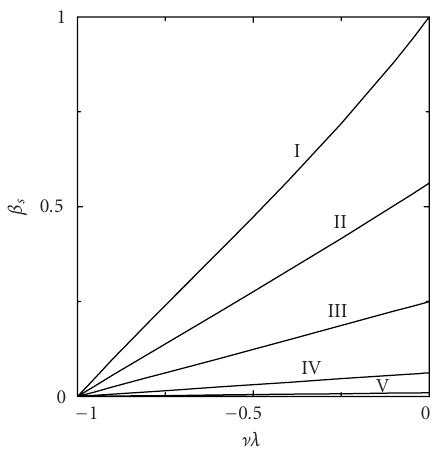
Figure 3.5. The variation of the smaller root β s of (3.10) as a function of ν λ for ν λ < 0 for various values of the nonintegrability parameter α . For λ = − 1, these states are staggered stationary localized states. Curve I: α = 1 . 0, curve II: α = 0 . 75, curve III: α = 0 . 5, curve IV: α = 0 . 25, and curve V: α = 0 . 10.